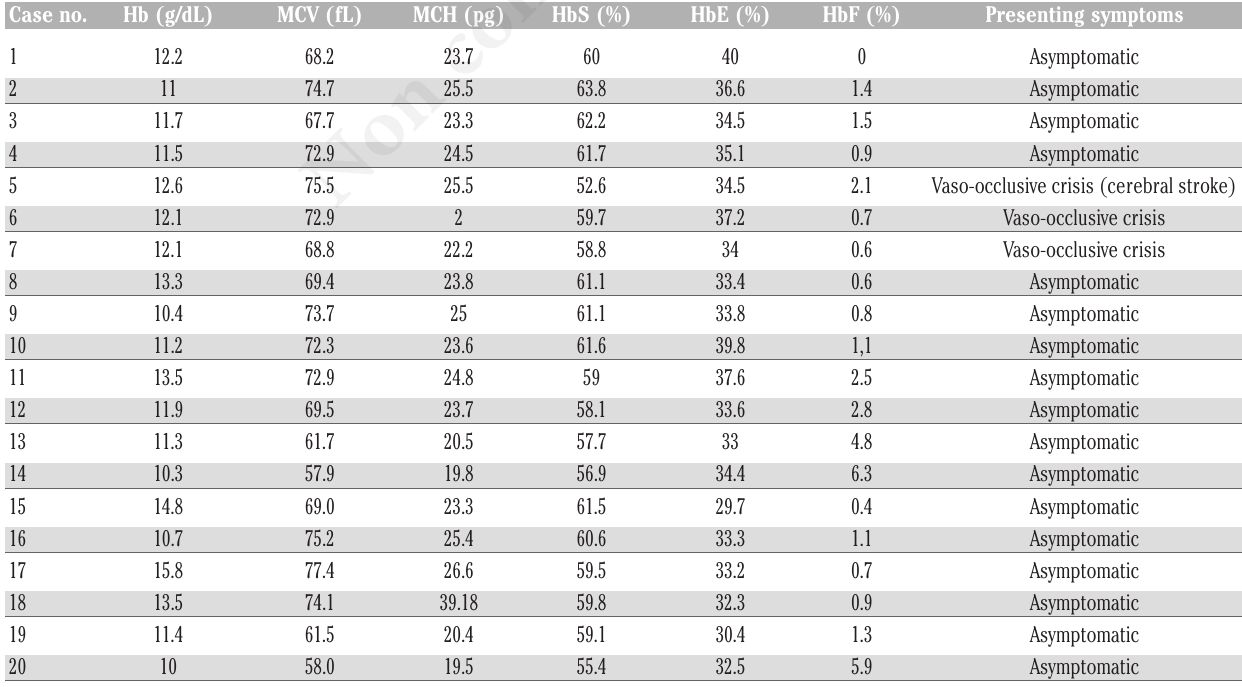
Table 1. Clinical and laboratory characteristics of patients with hemoglobin S and E. Case